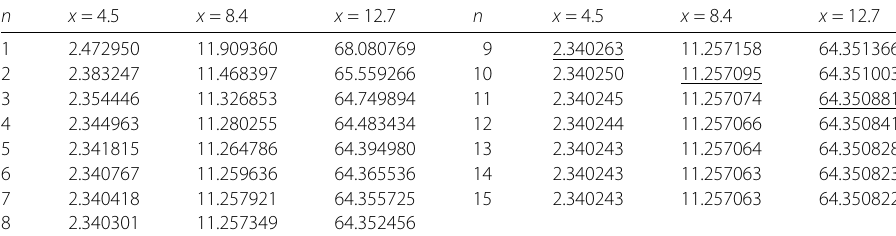
Table 1 Some numerical results for calculation of Γ q ( x ) with q = 1 and n = 1,2, ... ,15 of Algorithm 2